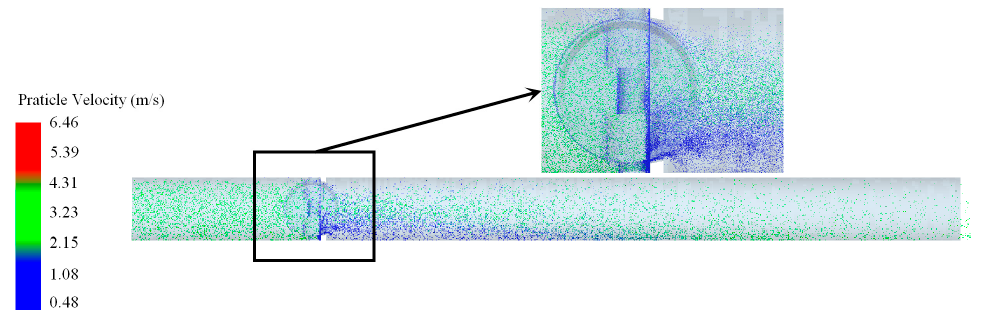
Figure 12. Particle distribution cloud map.